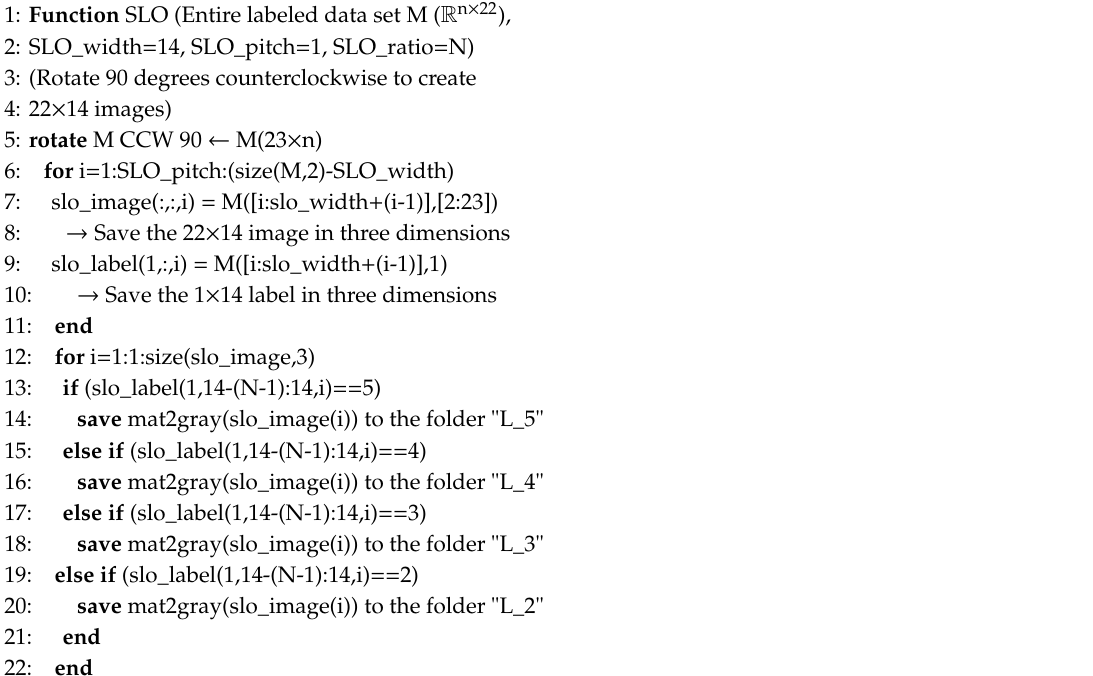
Algorithm A2 Pseudocode for assigning the representative label to a single window composed of the multiple labels